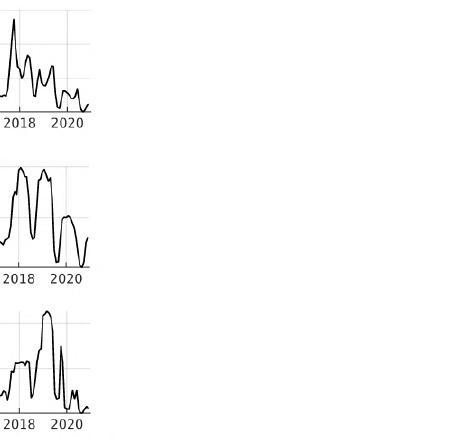
Figure 16. Impact of riverine heat inflow to the sea ice in 75–81 ◦ N in the Kara Sea (60–100 ◦ E), Laptev Sea (90–140 ◦ E), and East Siberian Sea (140–180 ◦ E) and adjacent water area. Kara sea ( a ), Laptev Sea ( b ), East Siberian Sea ( c ). Time-series of sea ice volume difference (A2-A0) relative to the annual mean of A0 (in %).